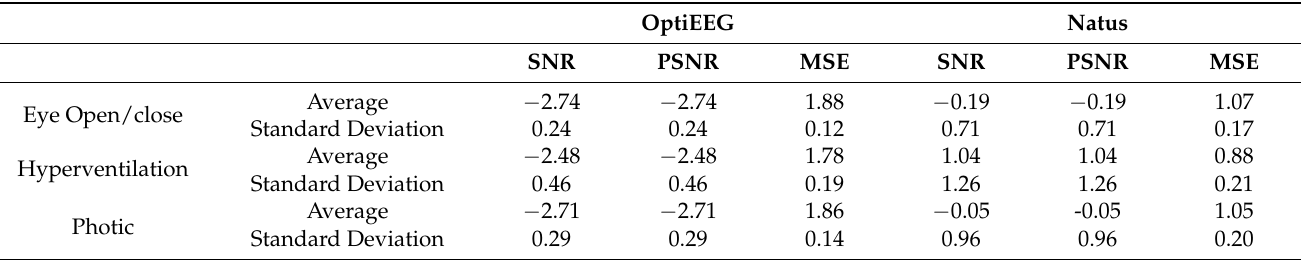
Table 3. Signal analytics